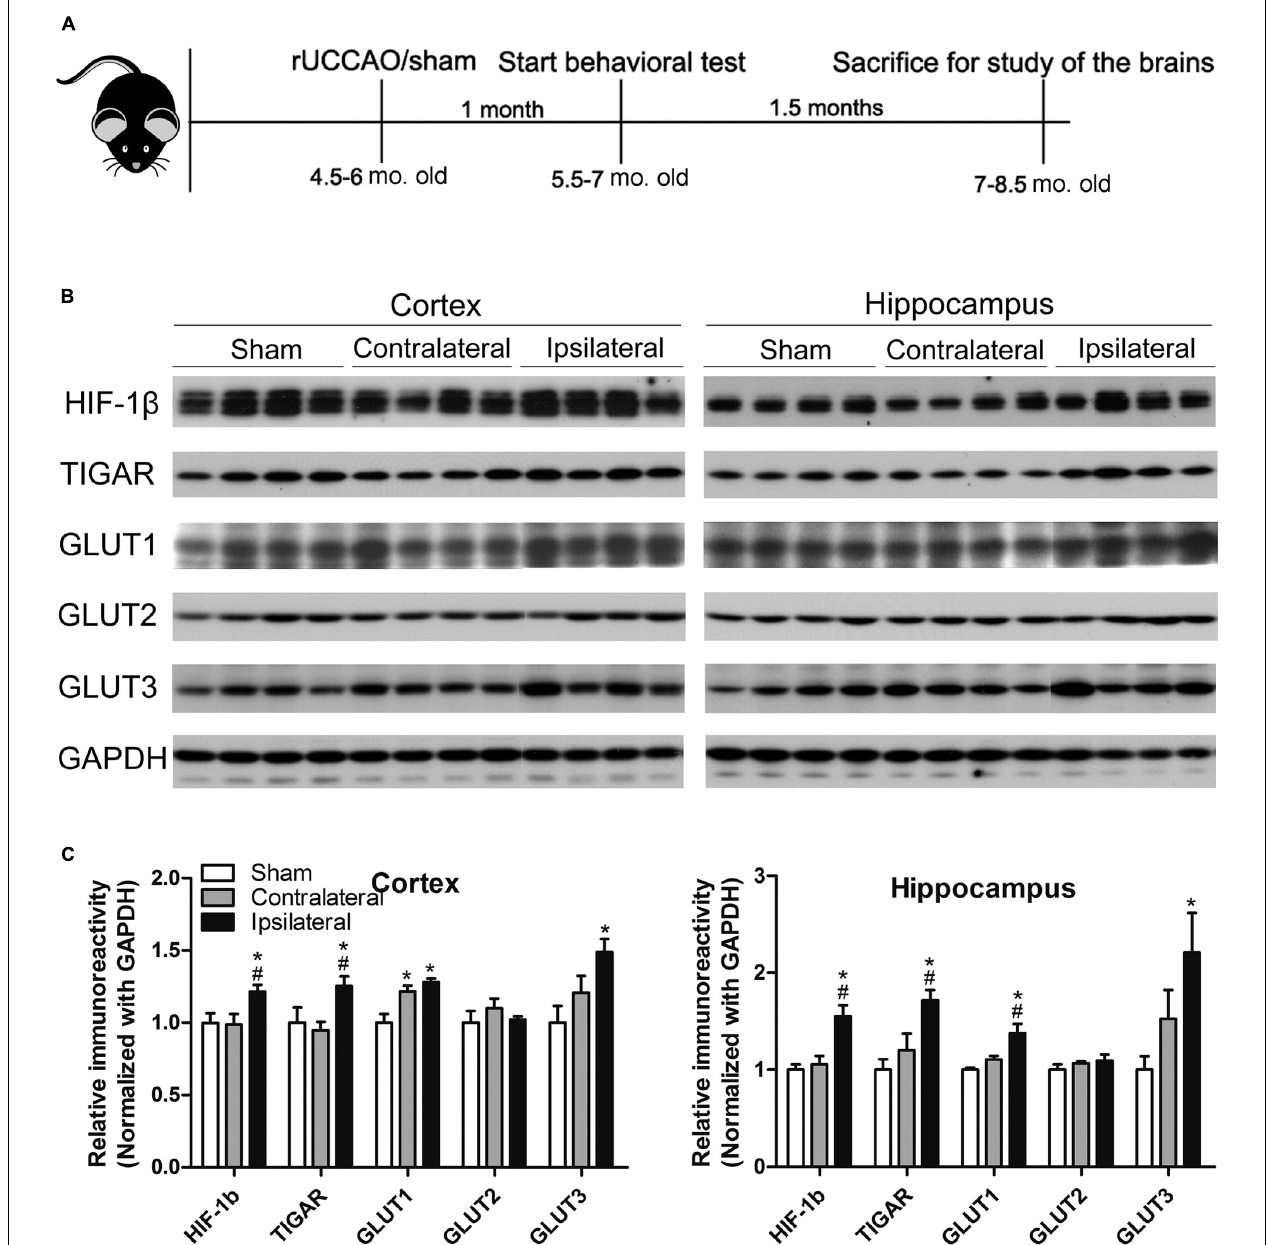
FIGURE 1 |Animal study design (A) and verification of the UCCAO model (B,C). Homogenates of the cortices and hippocampi of mice 2.5 months after sham or UCCAO surgery were analyzed byWestern blots developed with the indicated antibodies (B) . Each lane represents an individual mouse sample.